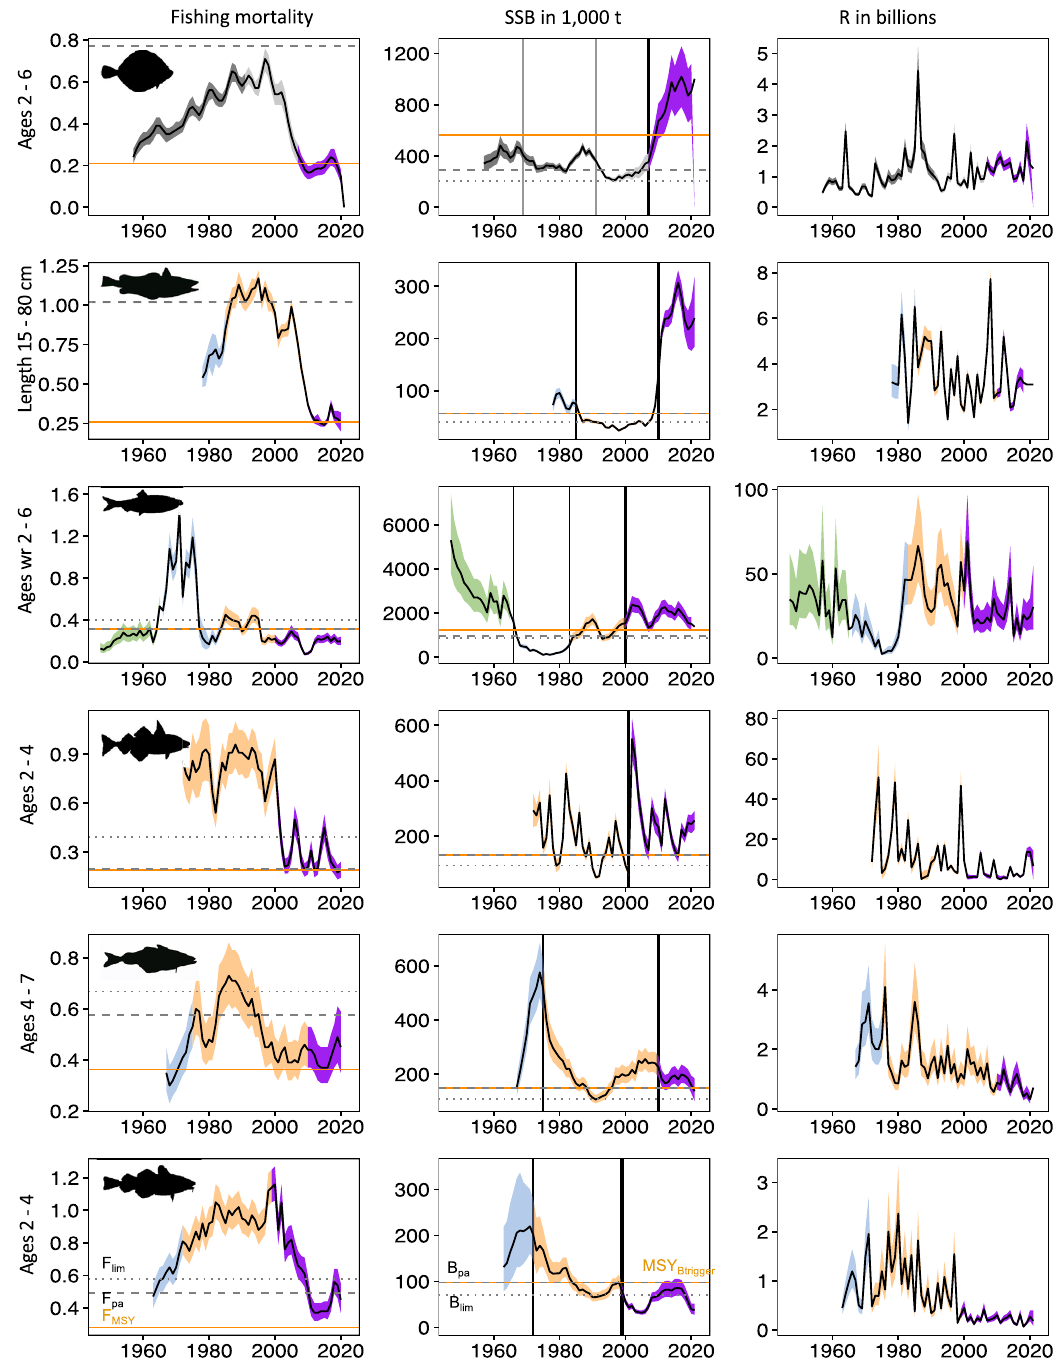
Figure 1. Abrupt changes in North Sea fish stocks. Time series of fishing mortality (F), spawning stock biomass (SSB) and recruitment (R). Black vertical lines in SSB indicate abrupt changes detected by both statistical change point analyses. Grey ranges and vertical lines in SSB for plaice indicate abrupt changes detected by the BinSeg algorithm only. Coloured ranges show identified SSB periods (see also Table 1); horizontal lines indicate management reference points; left column—F level aiming at Maximum Sustainable Yield (F MSY ), precautionary level of F (F pa ), limit reference point of F (F lim ); middle column—Level of SSB triggering specific action in management (MSY B trigger ), precautionary level of SSB (B pa ), limit reference point of SSB (B lim ) 3